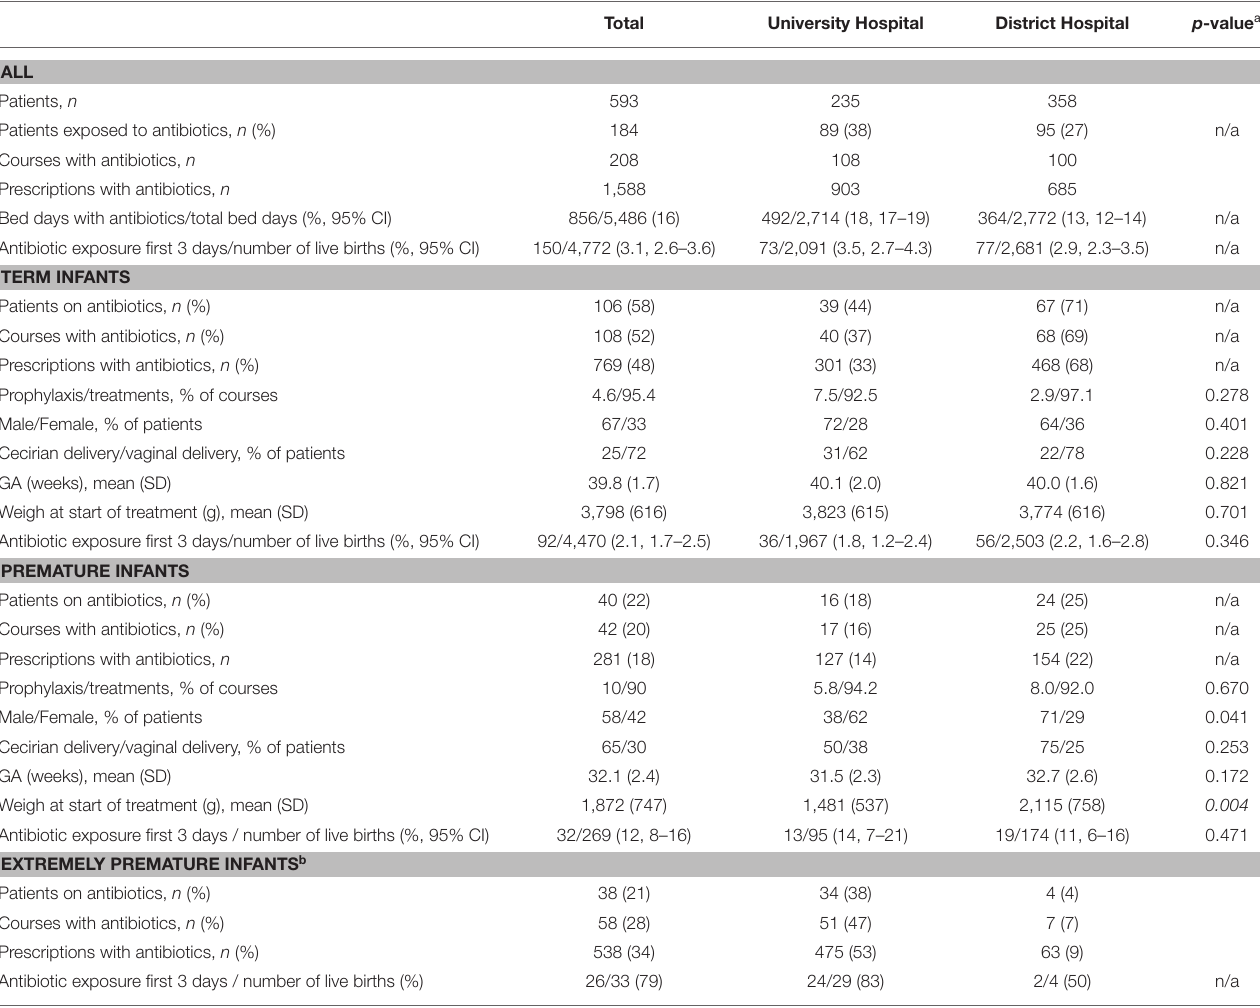
TABLE 1 | Characteristics of neonates receiving antibiotics in two different Norwegian neonatal units in 2017.